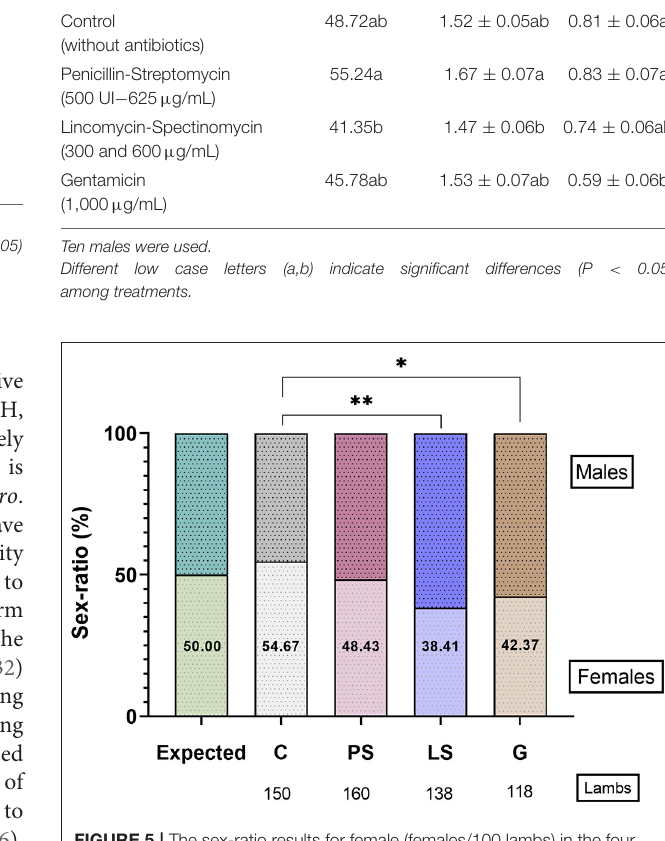
FIGURE 5 | The sex-ratio results for female (females/100 lambs) in the four experimental groups: Control (C), without antibiotics; Penicillin-Streptomycin (PS), (500 UI) − 625 µ g/mL, respectively; Lincomycin-Spectinomycin (LS), 300–600 µ g/mL, respectively; and Gentamicin (G) 1,000 µ g/mL. 371 ewes were inseminated with sperm doses from 10 males. * P ≤ 0.05, ** P ≤